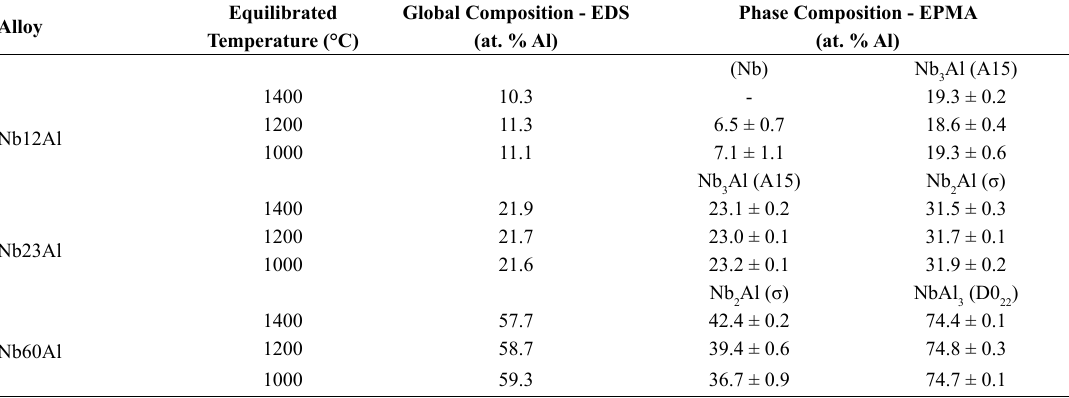
Table 5. Composition limits of the phases of the Nb-Al system measured via EPMA.